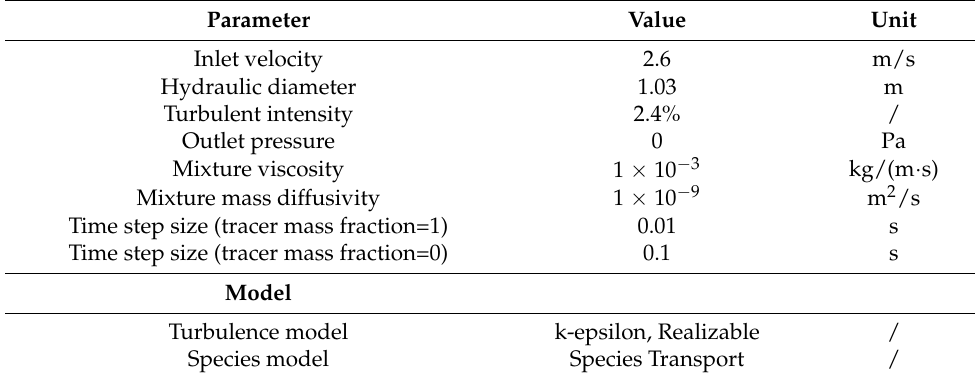
Table 1. Summary of boundary conditions set in the